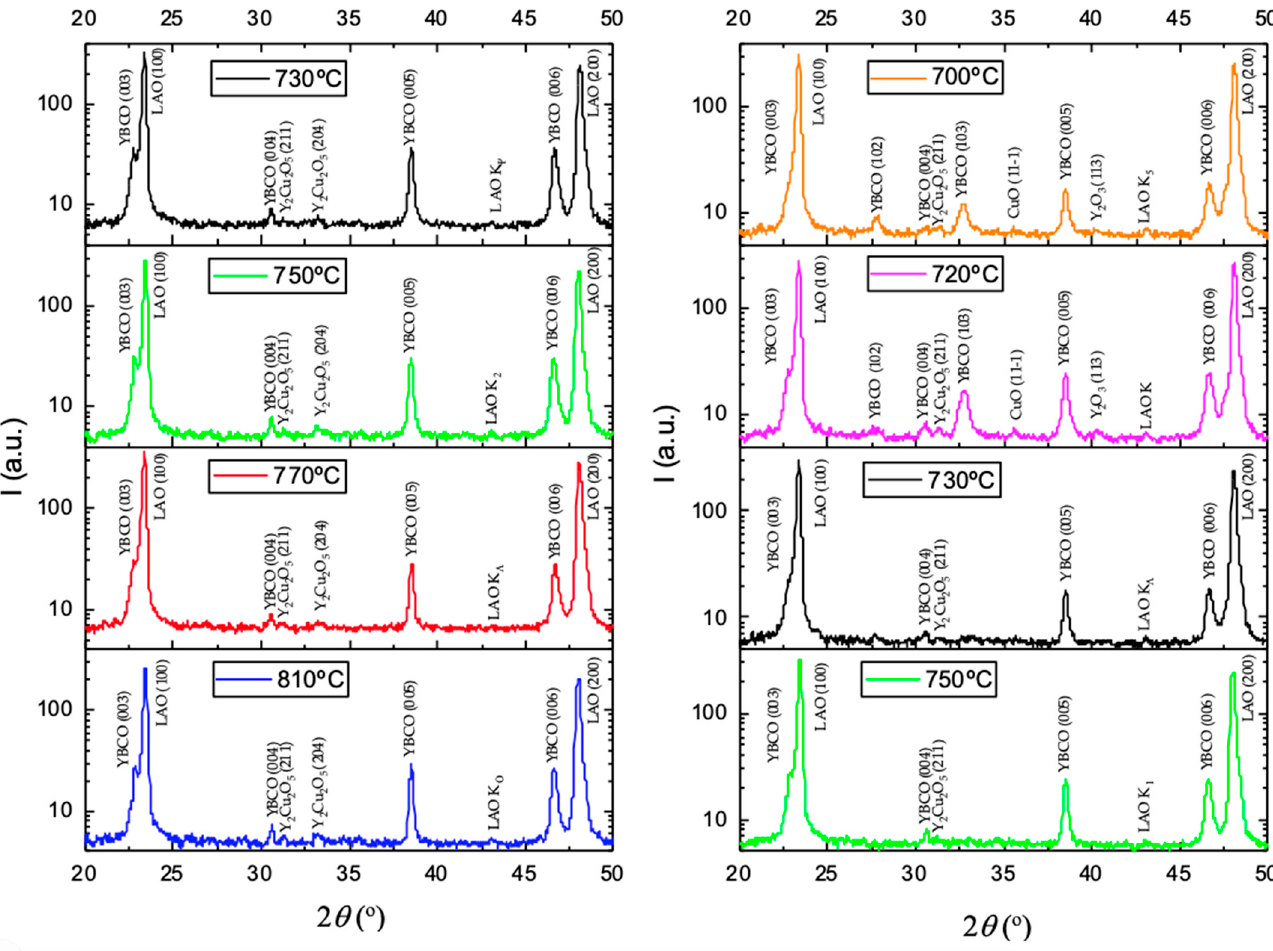
Figure 4. Integrated X-ray diffraction patterns obtained from eight YBCO films grown at different temperatures. The left panels correspond to the samples grown with the CTA method and the right ones to the samples grown with the FH method Regarding FH samples (right column), we can see that at 730 and 750 °C we observe the same epitaxial YBCO (00l) peaks as those obtained for the CTA samples and also a